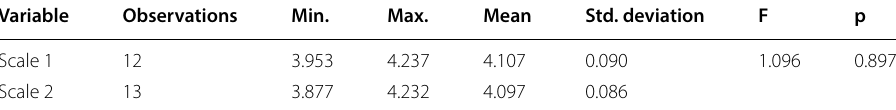
Table 4 Comparison of means for economic (scale 1) and social (scale 2) attributes